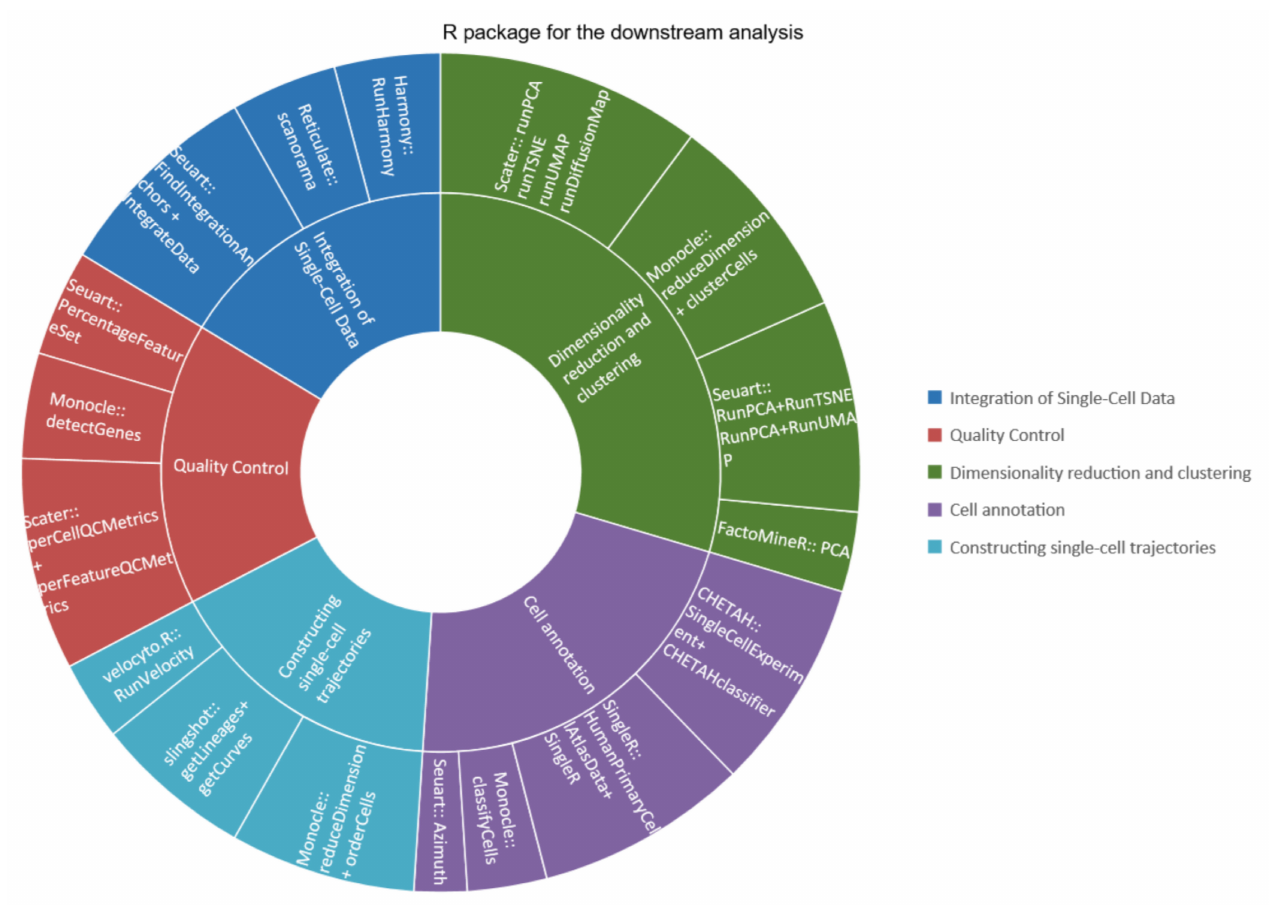
Figure 2. R package for the downstream analysis. The inner circle represents the main links of downstream analysis, and the outer circle represents the packages and functions that can realize these